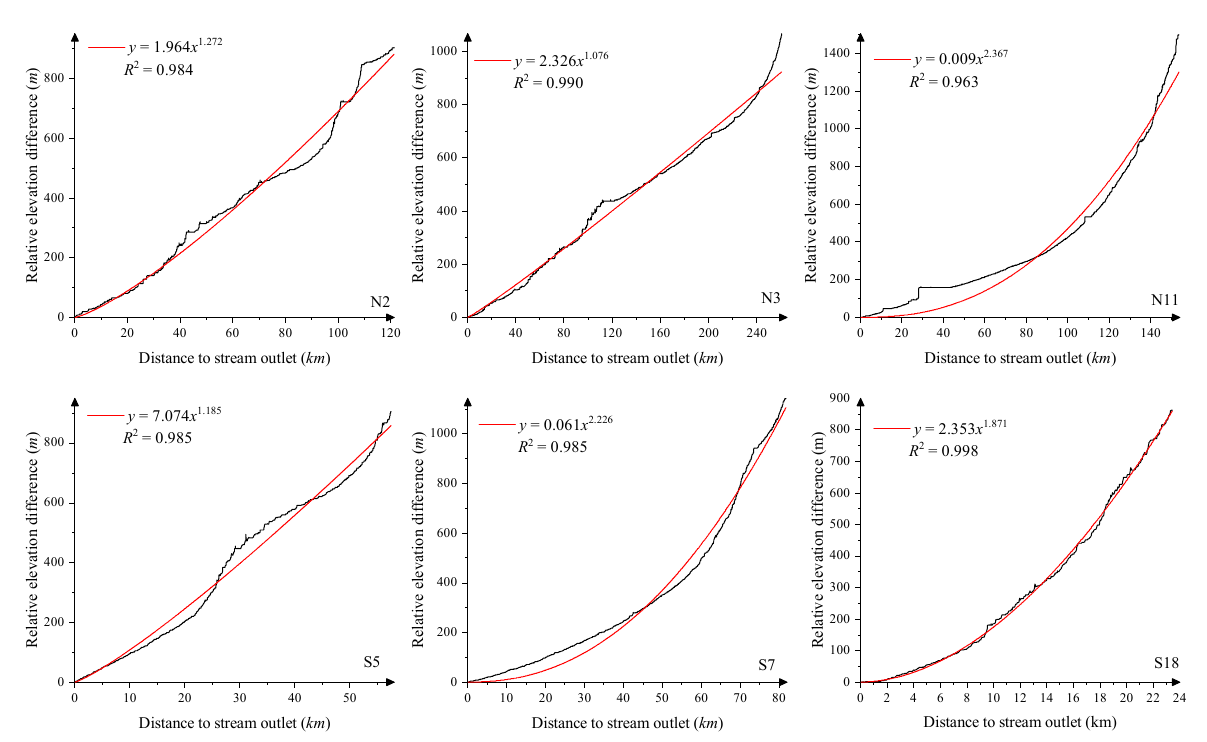
Figure 4. Sample maps of RLPFE in